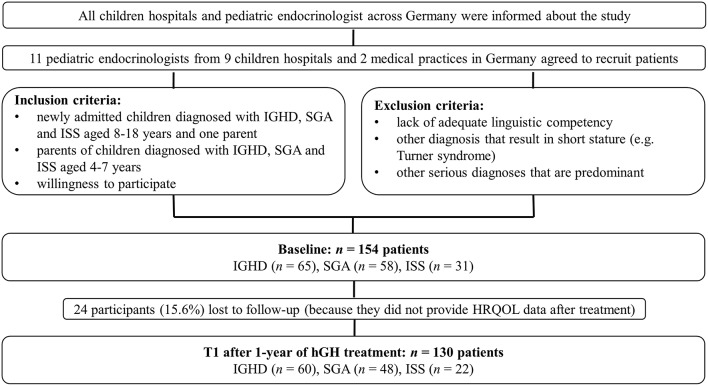
Flowchart of participant selection.